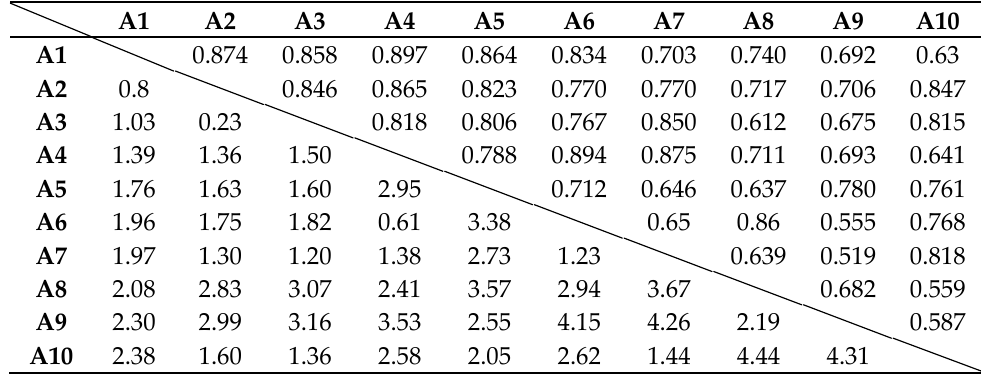
Table 3. Relationship between wind turbine correlation coefficients and turbine (short distance). A1–A10 are the IDs of the turbine sample.